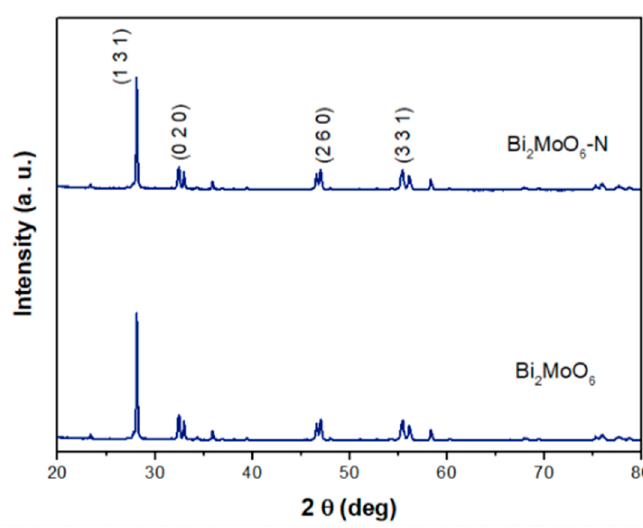
Figure 3. XRD patterns for Bi 2 MoO 6 and Bi 2 MoO 6 -N catalysts.